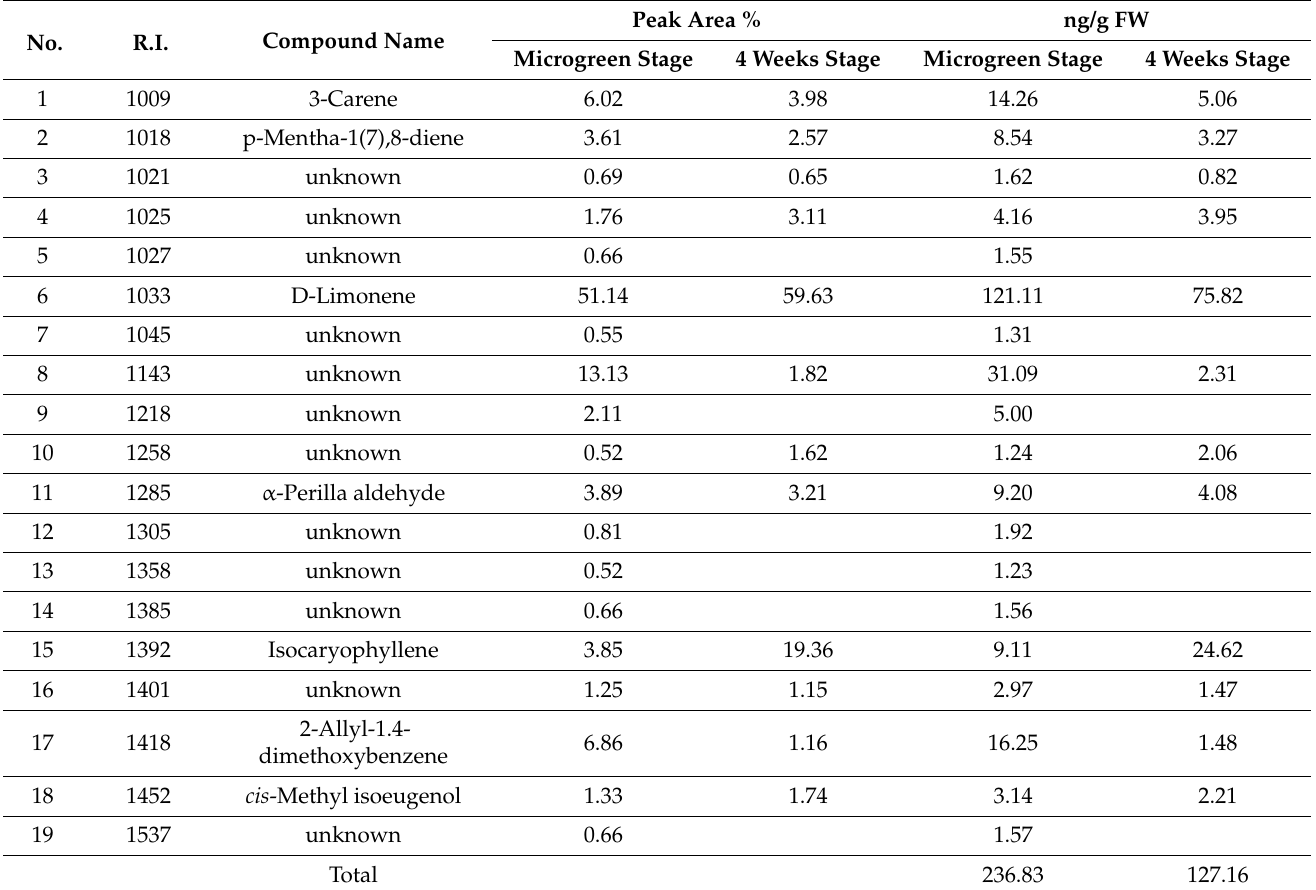
Table 3. Volatile organic compounds produced at microgreen stage by Chinese red basil (var. crispa ) and their semi-quantitative determination (ng/g